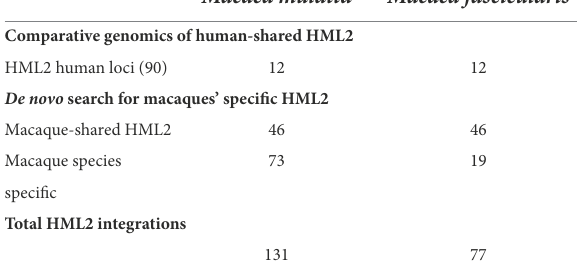
TABLE 2 Distribution of HML2 loci in Humans, Macaca fascicularis, and Macaca